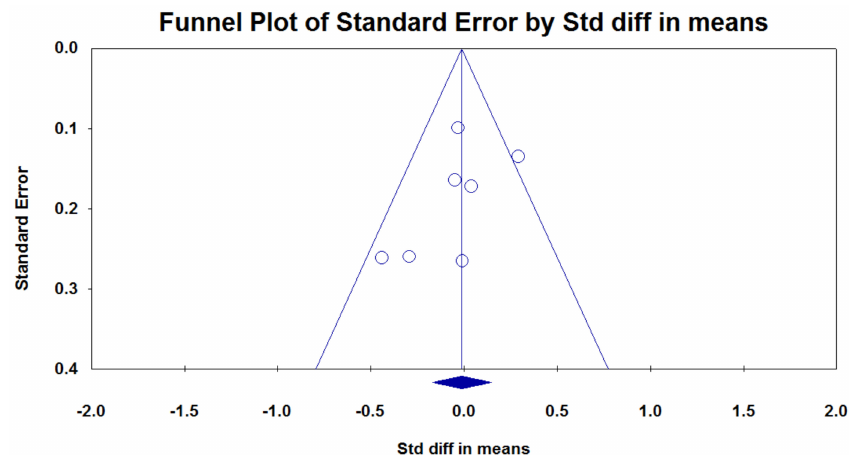
Figure 4. Funnel plots of publication bias: The funnel plot shows the observed mean di ff erences (on the x-axis) against standard errors (on the y-axis). In the absence of publication bias, the plotted points form a funnel